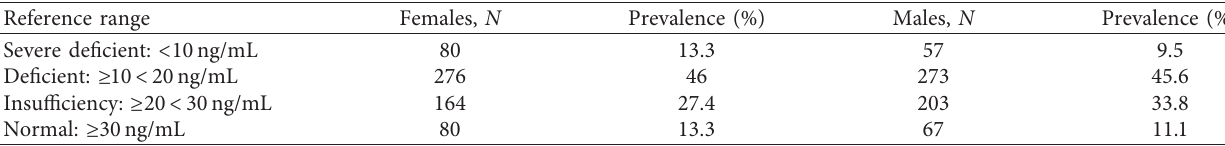
Table 3: Prevalence of different vitamin D nutritional statuses: severe deficient, deficient, insufficiency, and normal values in females and males.